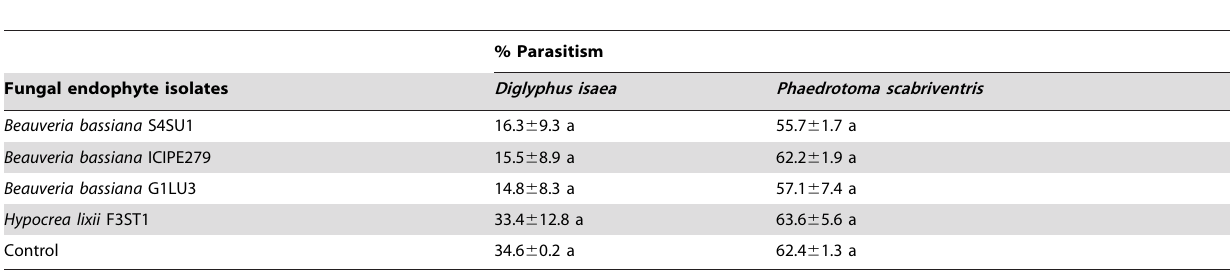
Table 1. Percent parasitism of Diglyphus isaea and Phaedrotoma scabriventris following exposure to Liriomyza huidobrensis reared on endophytically-inoculated host plant.